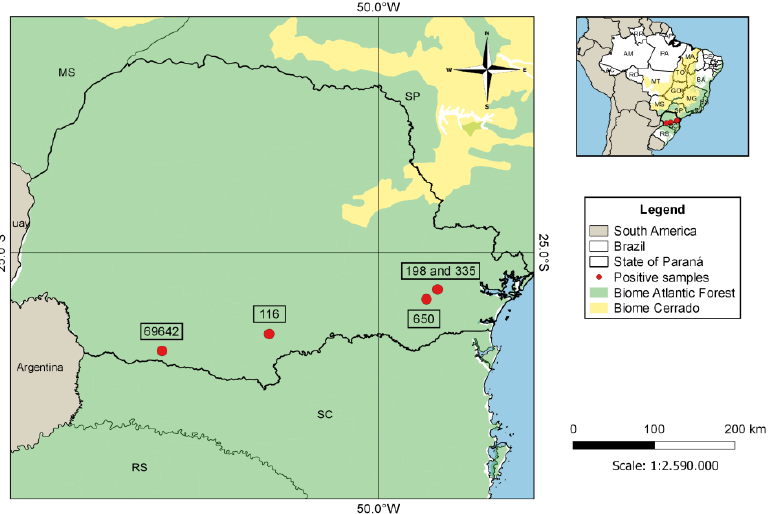
Figure 2. Distribution of the positive samples of Polychromophilus sp. isolates from Paraná state, Bra-